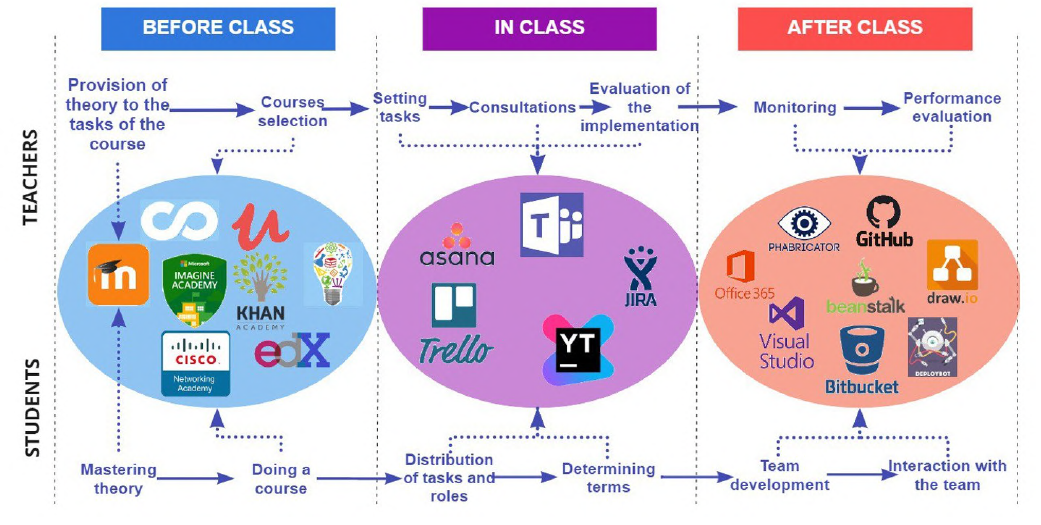
Figure 52: Presentation of paper